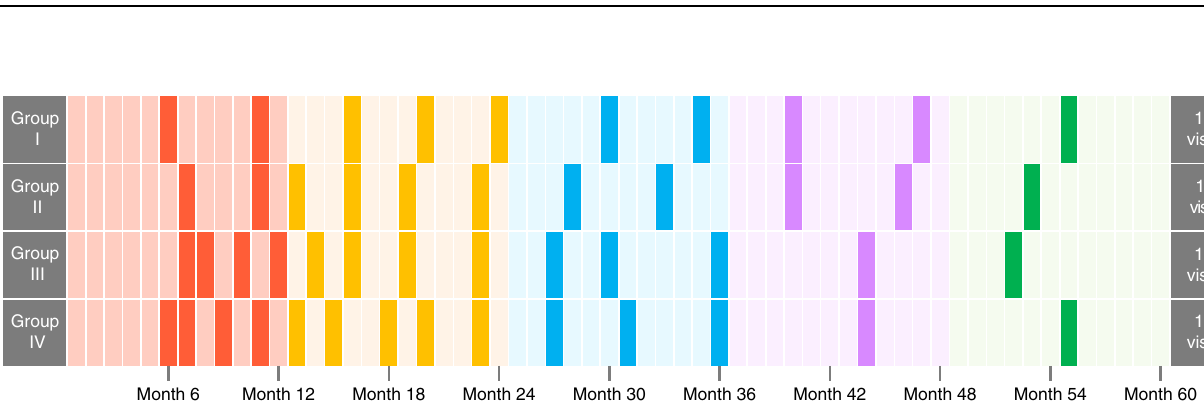
Fig. 5 Recommended risk-based surveillance arrangements for patients in each group from year 1 to 5. The darkened boxes of the grid represent the months recommended for